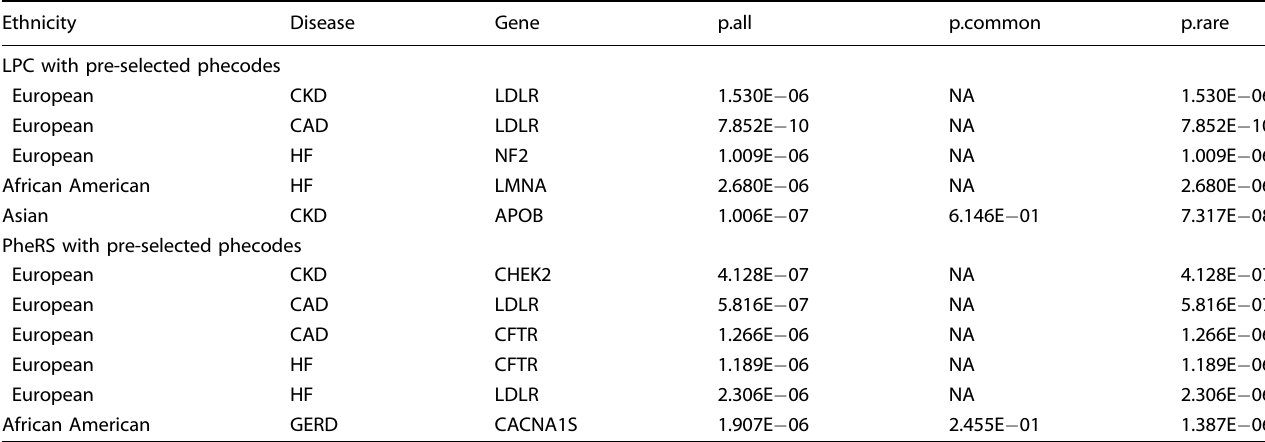
Table 3. Genes showing signi fi cant association with at least one disease using LPC and PheRS with pre-selected phecodes. Ethnicity Disease Gene